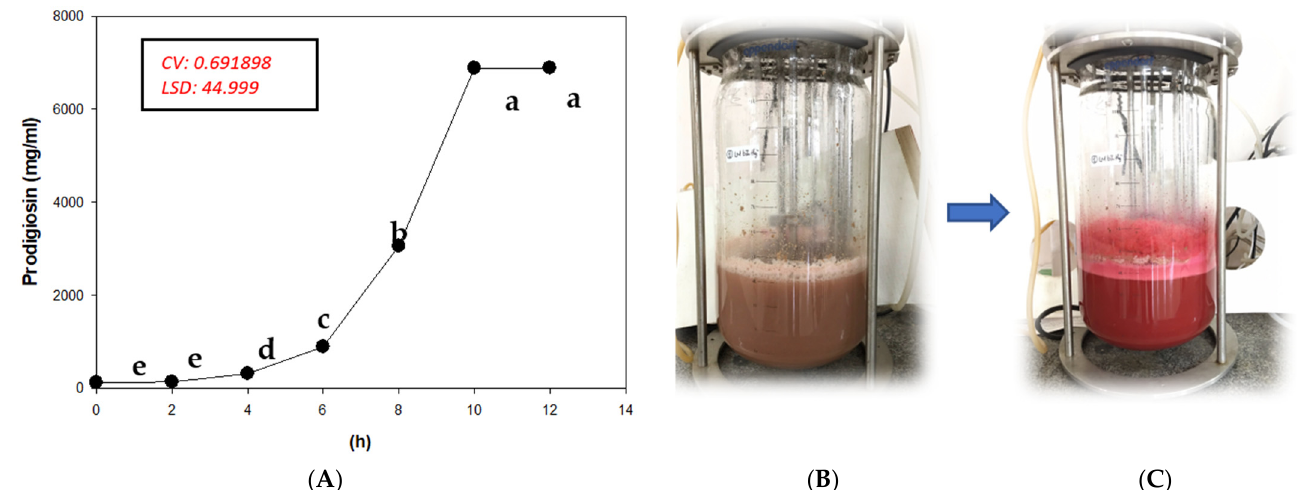
Figure 5. The scale-up prodigiosin production on a 14 L-bioreactor system. Liquid medium (4 L) containing 1% groundnut cake was fermented by S. marcescens TNU02 at 28 °C, with a shaking speed of 250 rpm, aeration of 1.0 vvm within 12 h. The recorded data of PG yield produced during the process of fermentation ( A ). The reaction tube of the 14 L-bioreactor system at 0 h ( B ) and 10 h ( C ) of fermentation. The experiments were conducted in triplicate and data were analyzed via the simple variance (ANOVA) then Duncan’s multiple range tests at p = 0.01 were performed. Values with the different letters are significantly different. LSD—Least Significant Difference; CV—Coefficient of Variation. Table 4. Research for scale-up prodigiosin production in a bioreactor system .